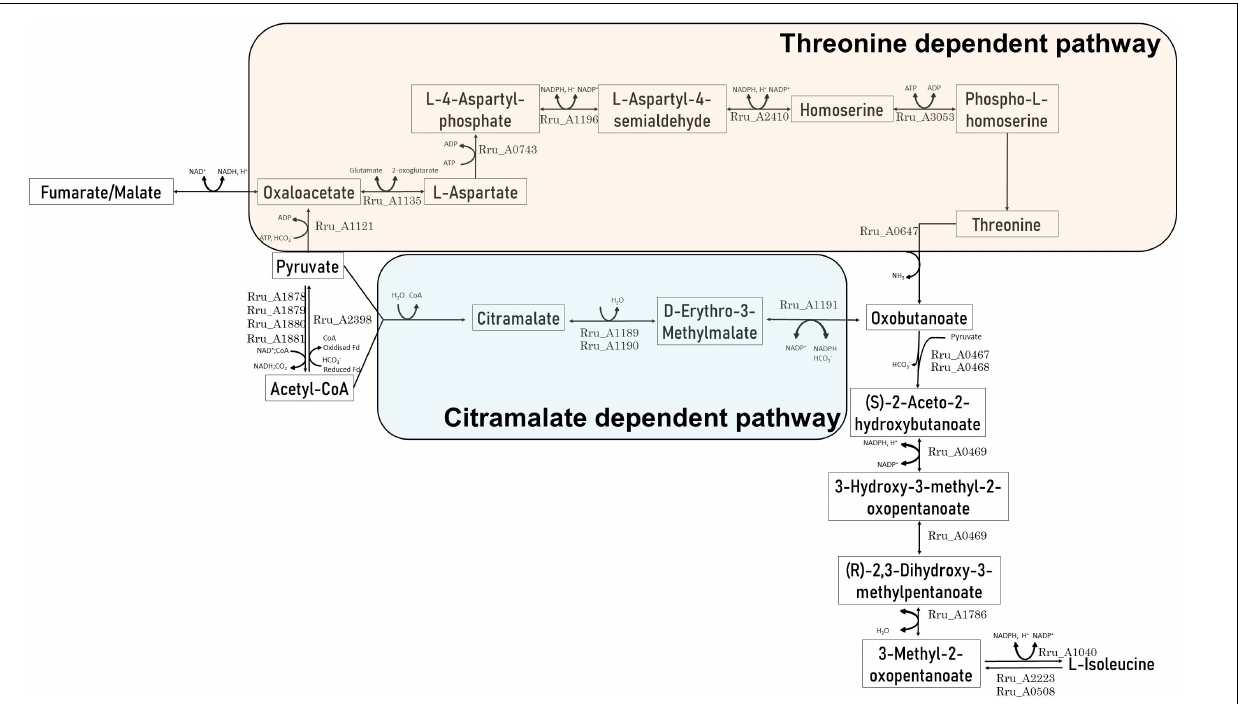
FIGURE 2 | Schematic representation of the citramalate-dependent and threonine-dependent isoleucine biosynthesis pathways in the presence of acetate as the carbon source.